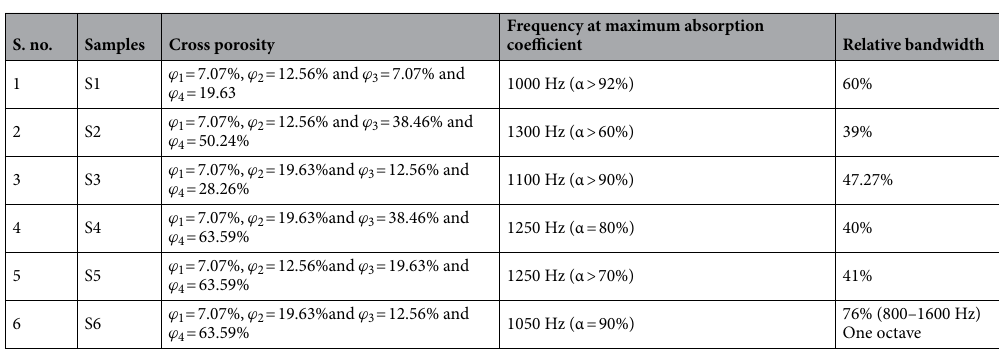
Table 2. Fractals CMPPs metamaterials parameters and its acoustic absorption behavior of a two-unit cells.